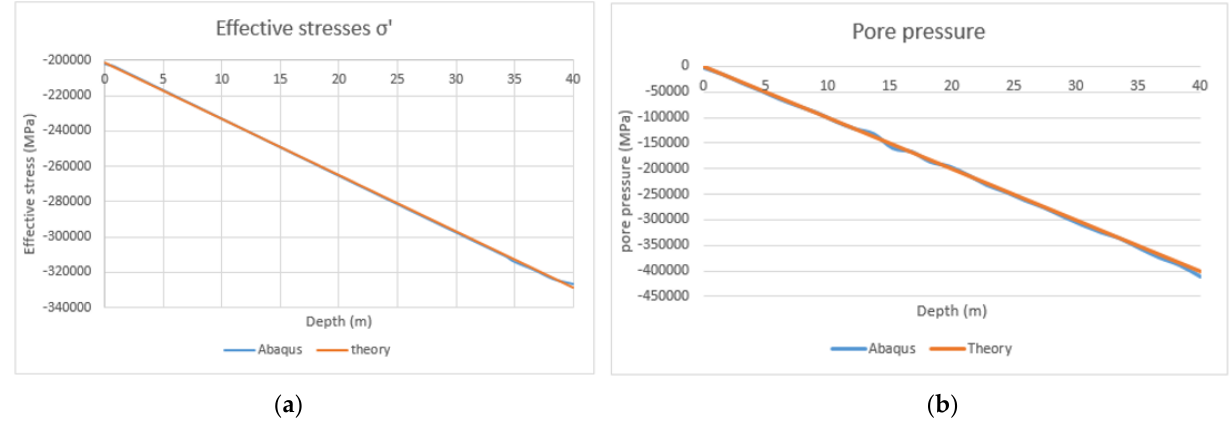
Figure 10. Lateral displacement: ( a ) Normal conditions, ( b ) Extreme sea state.